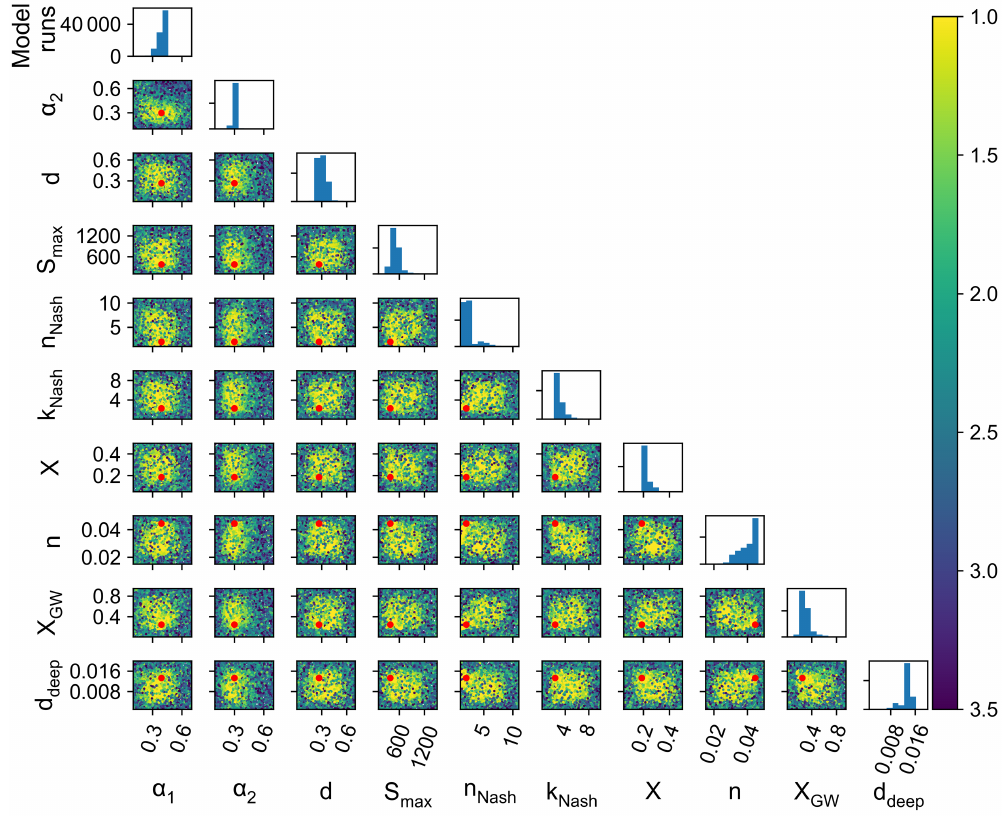
Figure 7. Parameter space post-calibration for the Ngounié calibration zone and the TRMM model. The yellow dots represent the best model runs and the red dots indicate the best parameter values. Example for TRMM model, Ngounié parameters.